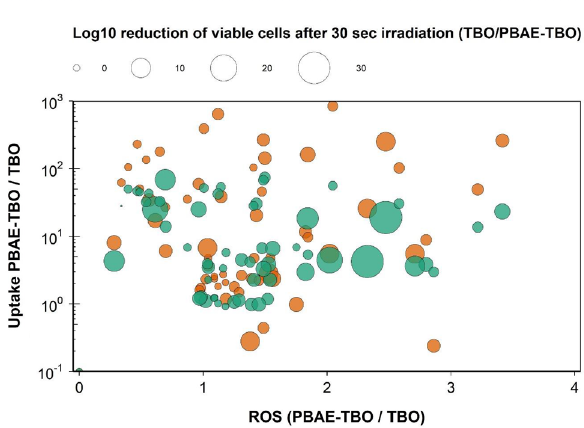
Figure 8. ROS produced by different PBAEs-TBO after 1 min irradiation compared to pure TBO.